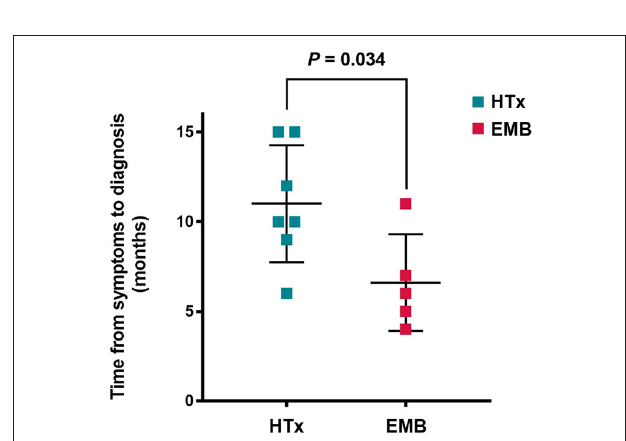
FIGURE 3 | Time from symptom onset to diagnosis of giant cell myocarditis. HTx, Heart transplantation; EMB, Endomyocardial